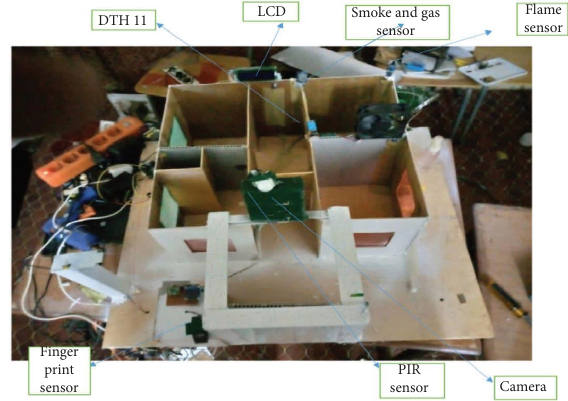
Figure 8: Top view of the home automation prototype.